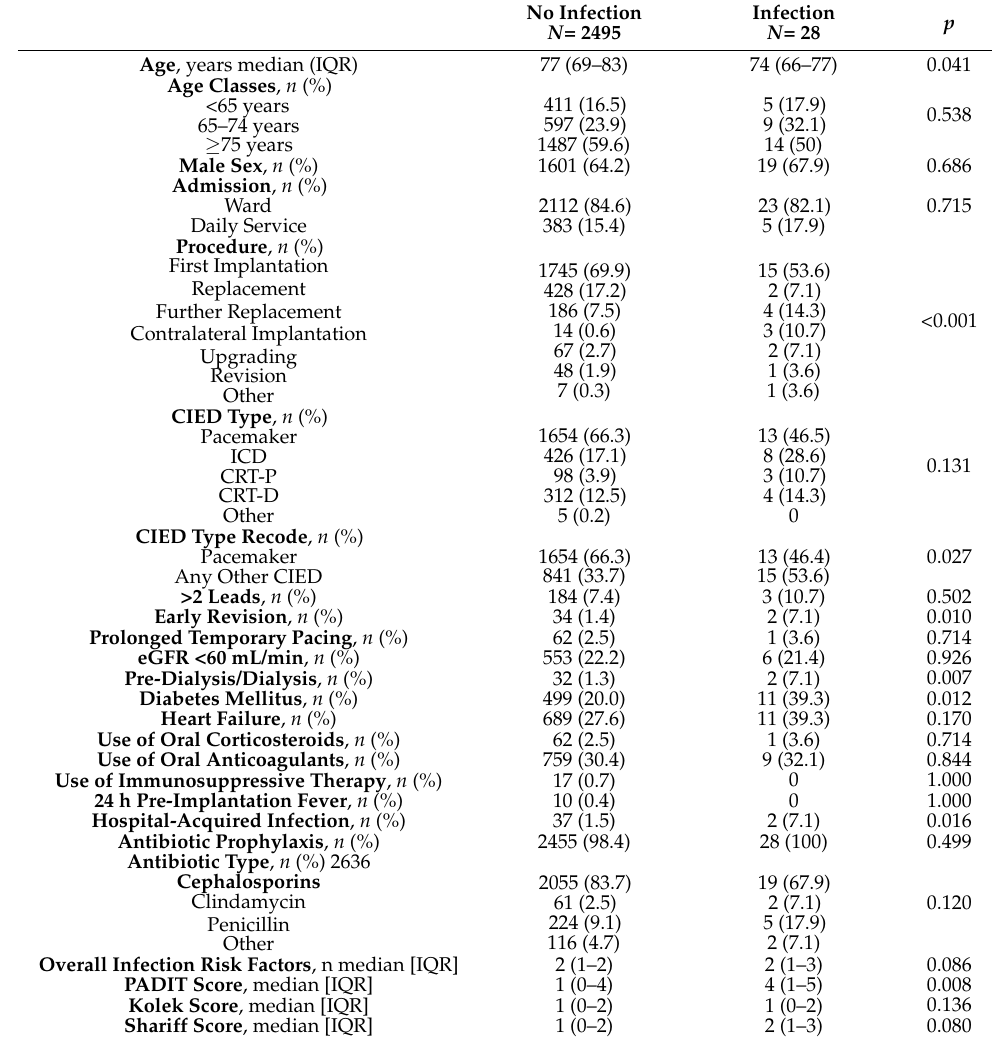
Table 2. Baseline characteristics according to Occurrence of Infection during